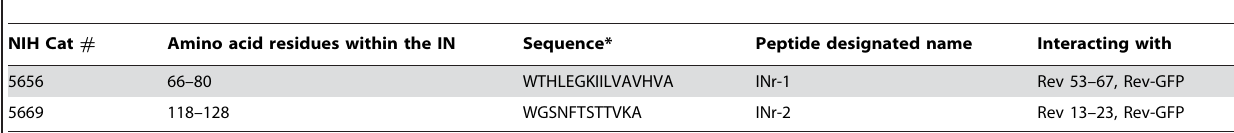
Table 1. Interaction of IN peptides derived from an IN peptide library, with Rev-GFP or Rev-derived peptides.